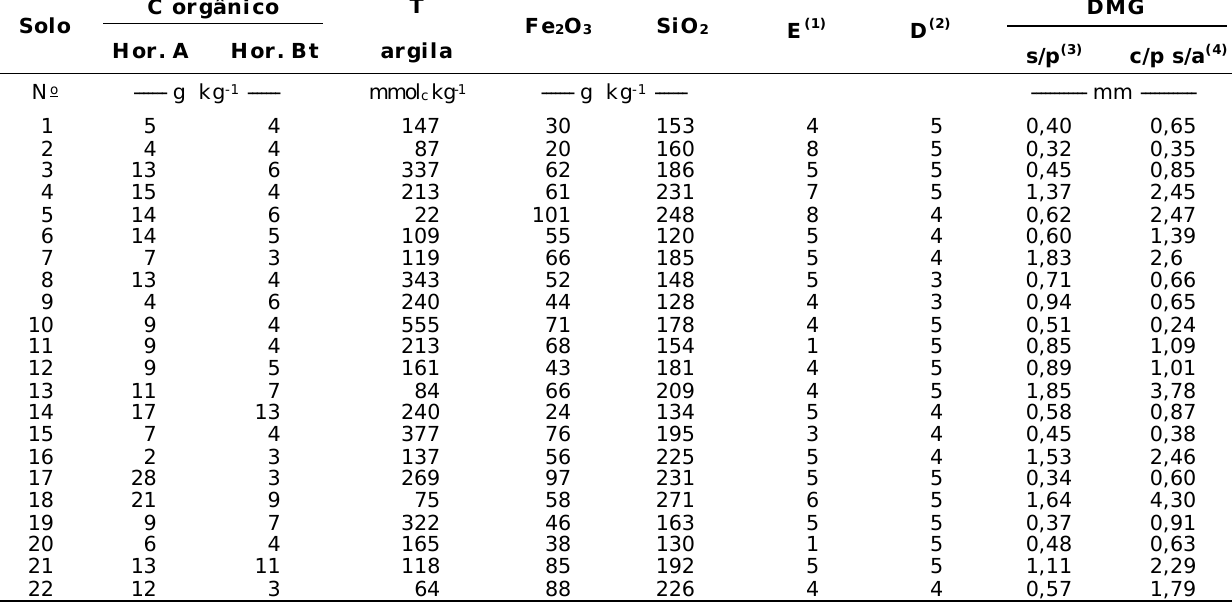
(1) Valores segundo as características estruturais; (2) Valores segundo a classe de drenagem: 5 = bem drenado, 4 = moderadamente drenado, 3 = imperfeitamente drenado; (3) sem pré-umedecimento; (4) com pré-umedecimento lento e descontando-se a contribuição da